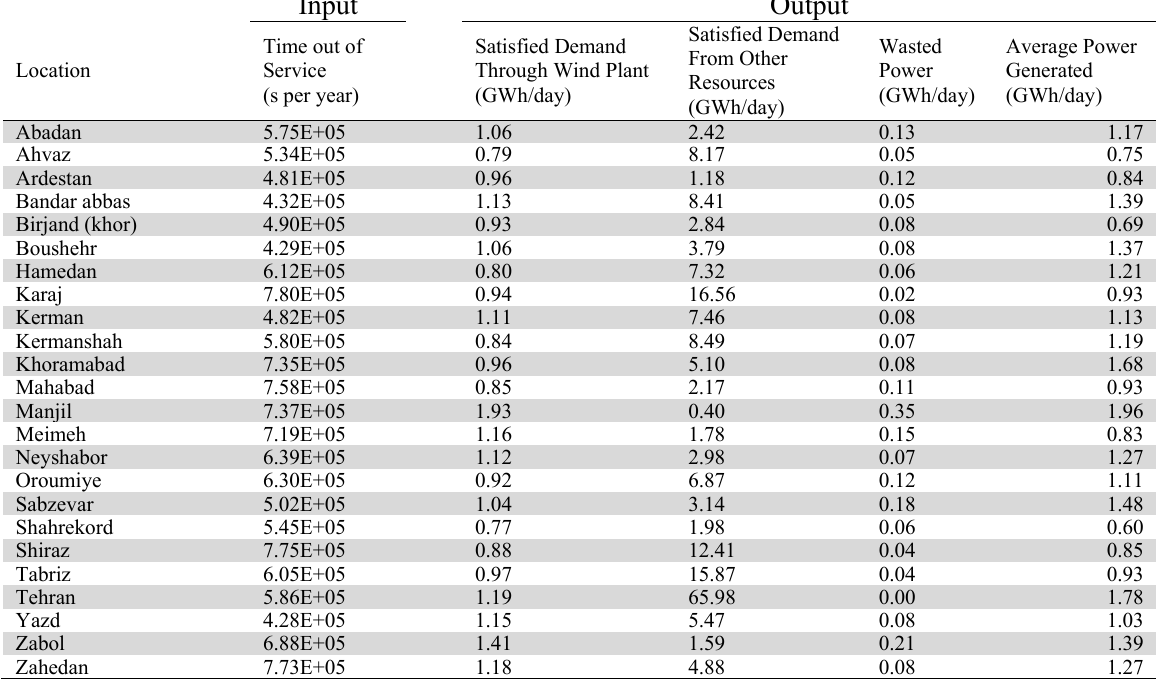
Results of simulation phase that are considered as input and output measures for DEA